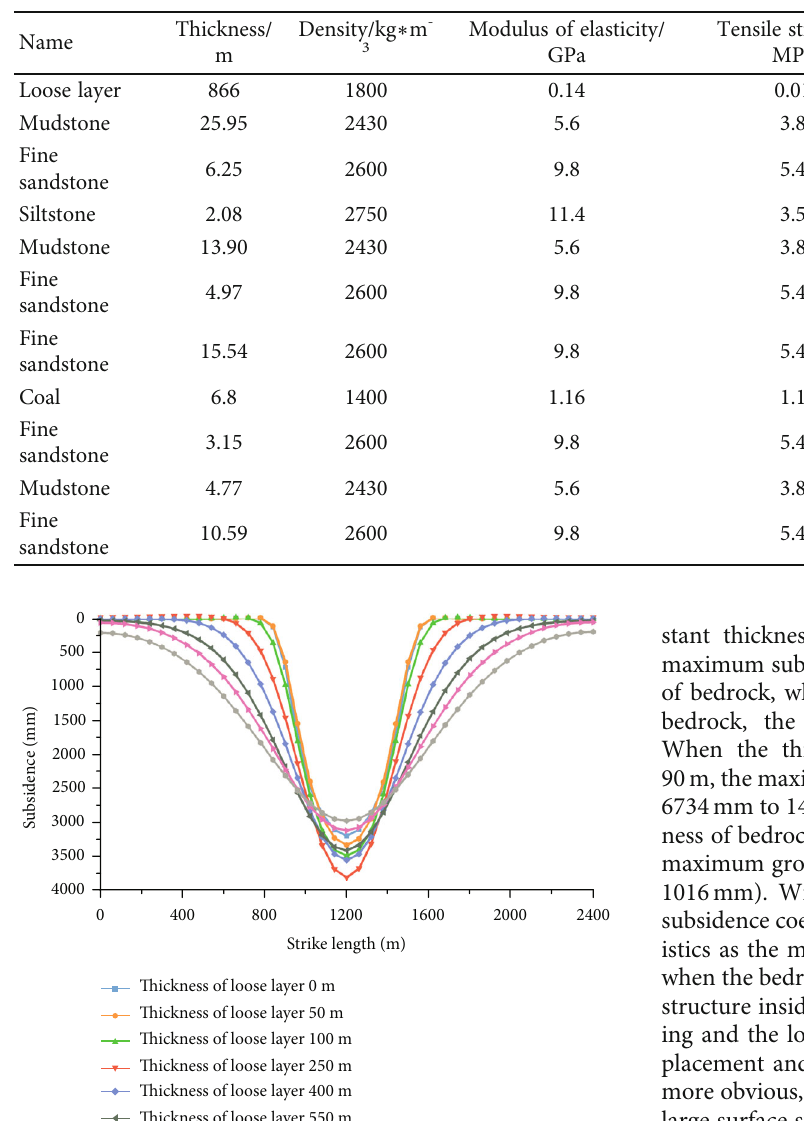
Table 1: Rock mechanics parameters.